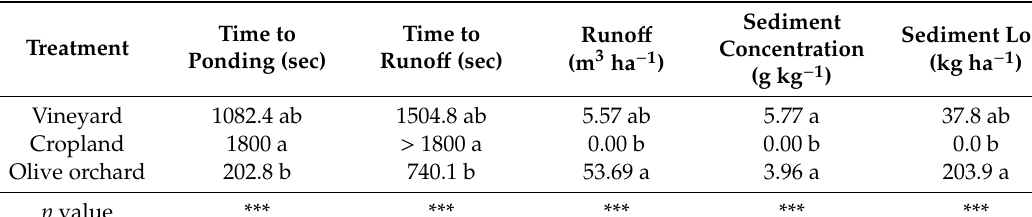
Table 2. Average values of time to ponding, time to runoff, runoff, sediment concentration and sediment loss, and one-way and Kruskal–Wallis ANOVA analysis. The effects of soil management on the vegetation cover and the overland flow properties. Small letters in the column represent the difference of treatment effects at p < 0.05. ***, statistically significant at p < 0.001.